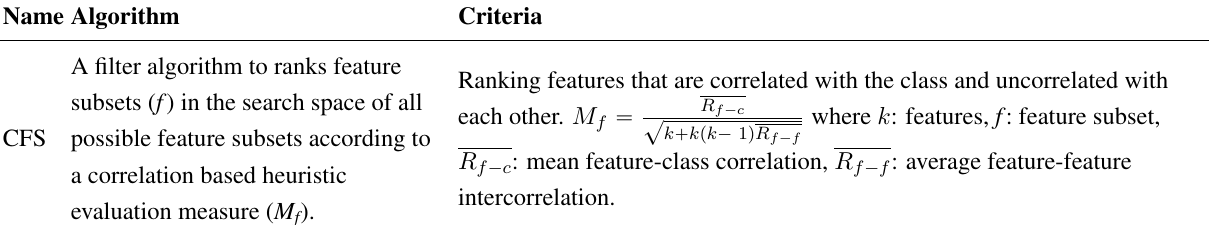
Table 4. Feature selection methods used in this